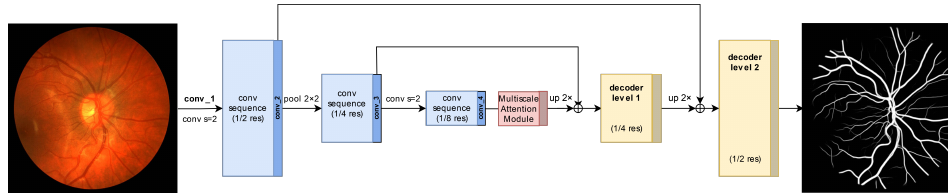
Figure 5. Scheme of the SMANet segmentation